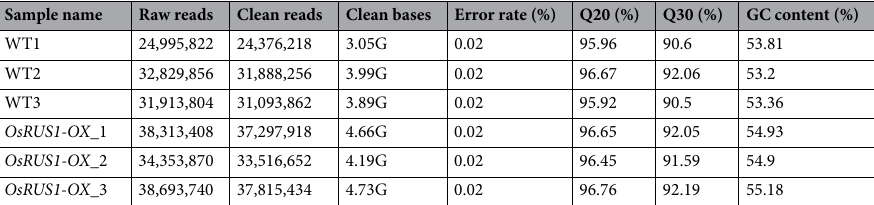
Table 1. Summary of sequence assembly after Illumina sequencing. Sample name, the name of samples; Raw reads, the original sequence data; Clean reads, filtered Raw reads, (subsequent biological information analysis was based on Clean reads); Clean bases, the number of Clean reads was multiplied by the length, and converted to G as the unit; Error rate, calculated by the formula: Qphred = − 10log 10 (E); Q20 and Q30,The percentage of bases for which the Phred value was larger than 20 and 30, respectively; GC content, the sum of the number of bases G and C was calculated as a percentage of the total base number. WT, the wildtype of ZhongHua11; OsRUS1-OX , the OsRUS1-GFP Overexpression transgenic line.